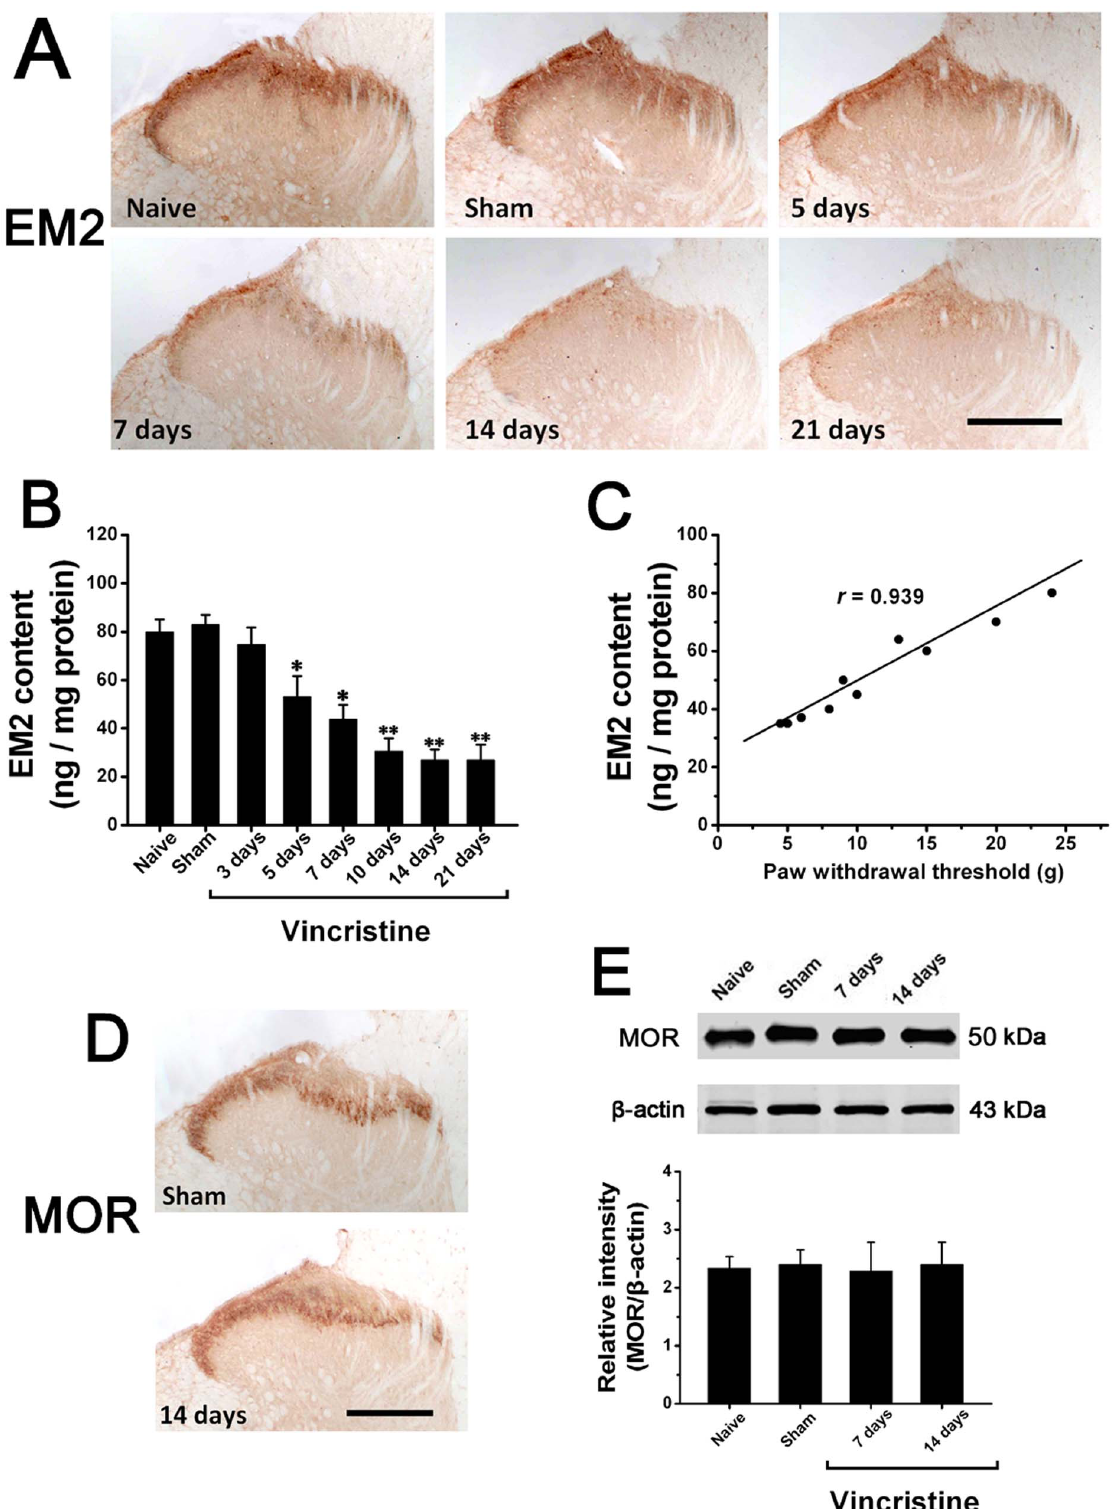
Figure 2. Spinal EM2 was significantly decreased in vincristine treated rats. (A) Compared to Sham group, EM2-like immunoreactivity in spinal dorsal horn of Vincristine group was significantly decreased. Bar=200 m m. (B) Compared to Naive group and Sham group, ELISA showed that spinal EM2 content was significantly decreased in Vincristine group. (C) The content level of EM2 was found to be significantly correlated to the paw withdrawal threshold in Vincristine group (P , 0.001, r=0.939). (C) With regard to MOR-like immunoreactivity in spinal dorsal horn, there was no difference between Sham group and Vincristine group. Bar=200 m m. (D) With regard to MOR expression in spinal cord, Western blot analysis showed that there was no difference between Sham group and Vincristine group. In vincristine treated rats, MOR expression was unchanged through the